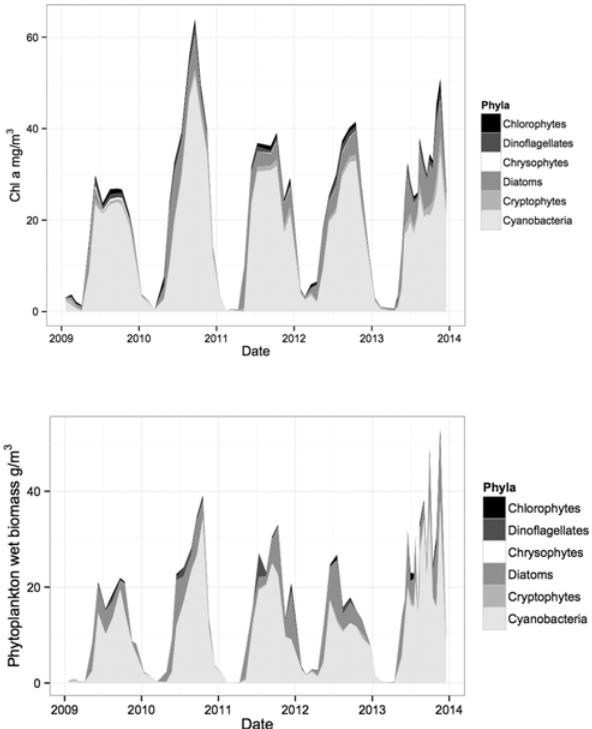
Fig 6. Dynamics of phytoplankton communities in Lake V õ rtsjärv (2009 – 2013) according to CHEMTAX (upper) and microscopy (lower).